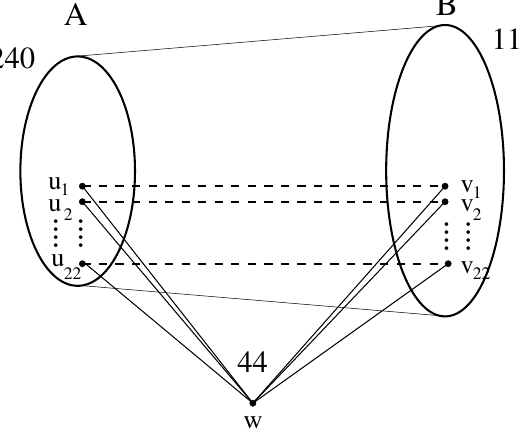
Figure 1: The smallest non-bipartite graph with integer Sombor